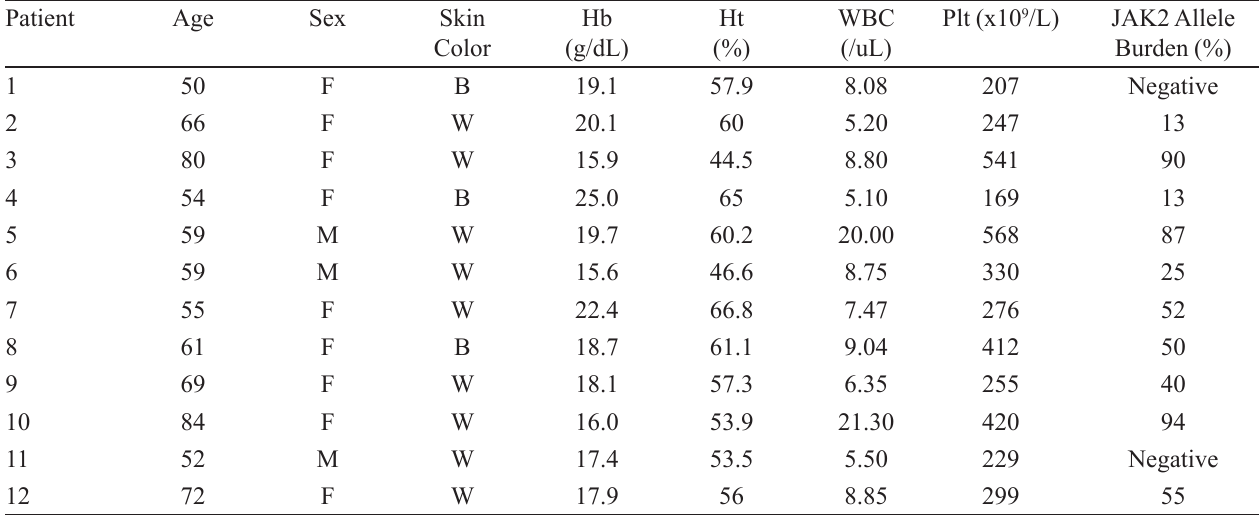
Abbreviations: PV, polycythemia vera; M, male; F, female, Hb, hemoglobin; Ht, hematocrit; WBC, white blood cell count; Plt, platelets; W, white; B,